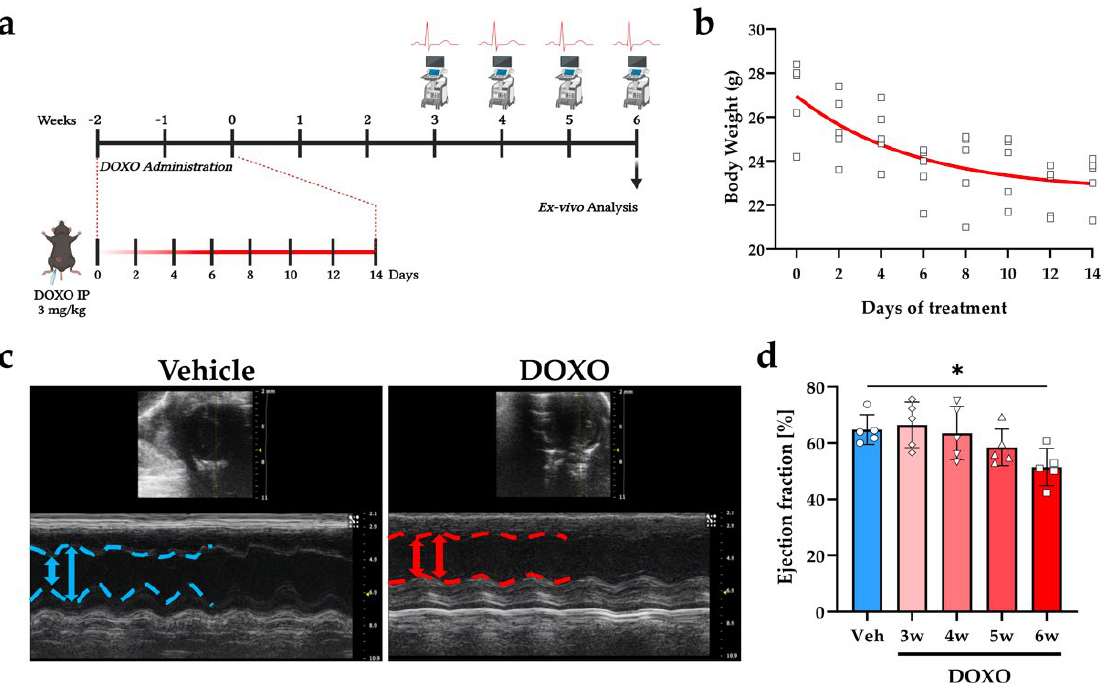
Figure 1. DOXO treatment leads to cardiac contractile dysfunction. ( a ) DOXO administration and ex vivo analyses protocol: study design. ( b ) Body weight evaluation during mouse treatment with DOXO. The nonlinear fitting line is shown in red. ( c ) Echocardiographic short-axis (top) and B-mode (bottom) views of hearts from vehicle- vs. DOXO-treated mice. These analyses were performed six weeks after completion of drug administration regimen. Blue/red lines and arrows represent left ventricle (LV) systolic and diastolic diameters in vehicle- and DOXO-treated mice, respectively. ( d ) Echocardiographic assessment of LV ejection fraction in vehicle- and DOXO-treated mice, at differ- ent time points after completion of DOXO administration. Bars represent the standard deviation (s.d.). Differences among the groups were determined using one way ANOVA with Dunnett’s test for multiple comparisons. ( n = 5 mice for each group; *, p < 0.05). DOXO, doxorubicin; Veh, vehicle.